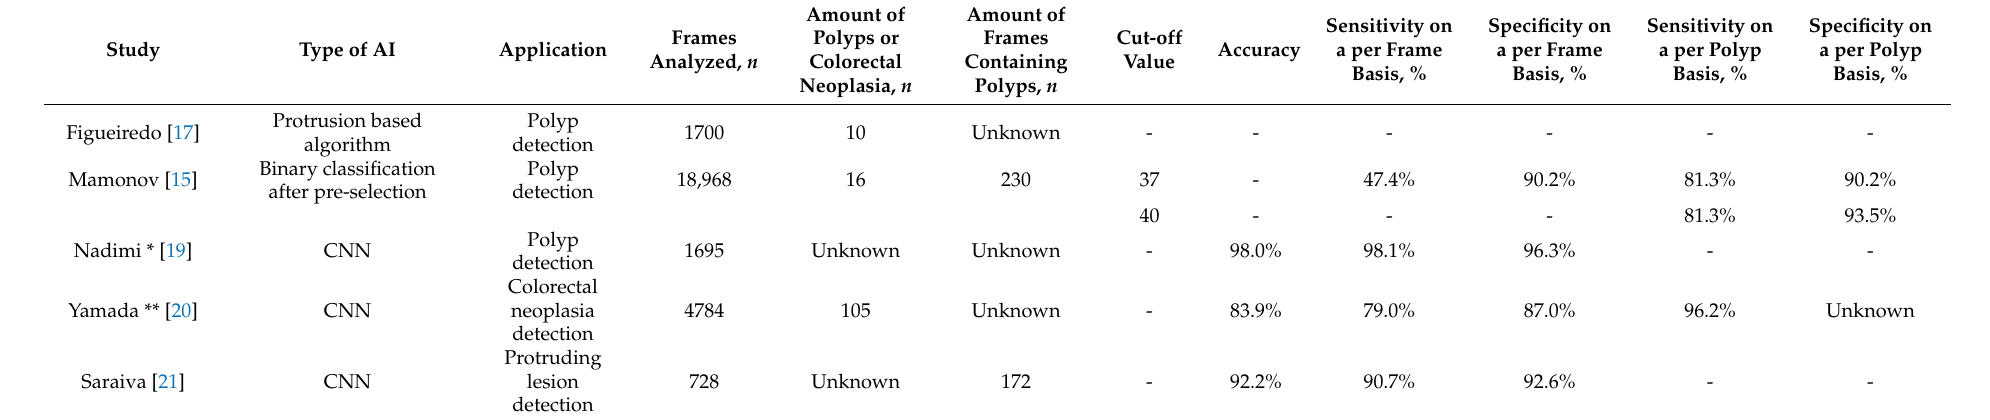
Table 5. Results of the five included studies examining computed polyp- or colorectal neoplasia detection in